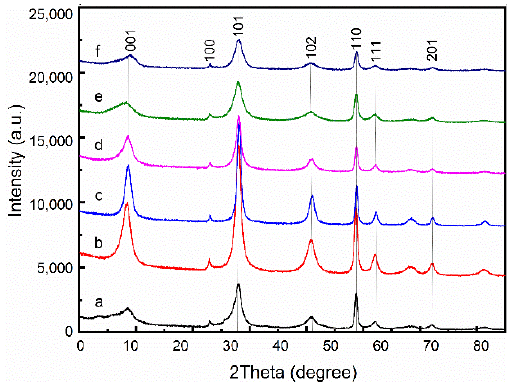
Figure 8. X-ray diffraction patterns images of as-prepared Mg(OH) 2 . ( a ) Additive free; ( b ) 0.2 g/L; ( c ) 0.4 g/L; ( d ) 0.6 g/L; ( e ) 0.8 g/L; ( f ) 1.0 g/L. Table 3. The peak intensity ratio of (101) crystal plane to (001) crystal plane of electrolytic products with different PEG-4000